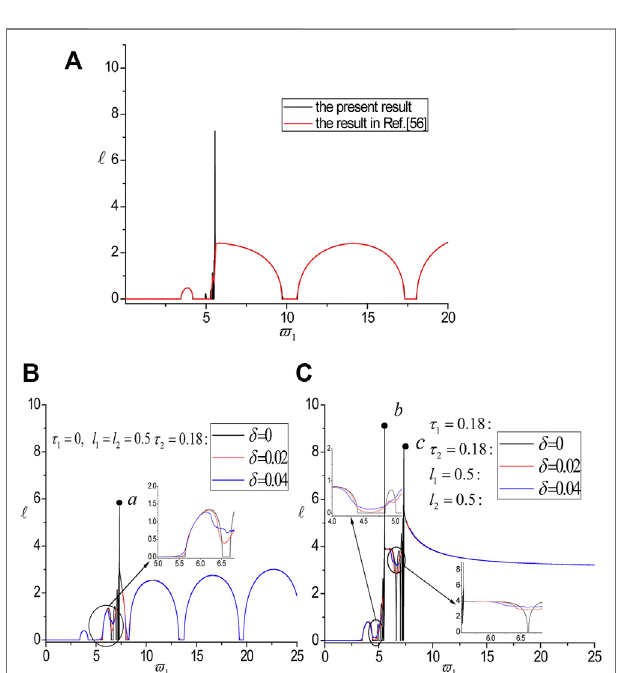
FIGURE 2 | The results obtained by the current method are compared with the reference (A) . The in fl uences of δ on the localization factors and the disordered parameters are internal characteristic length τ 2 of the second sub- layer (B) and the internal characteristic length and the external thickness of sub-layers A and B (C) , respectively.